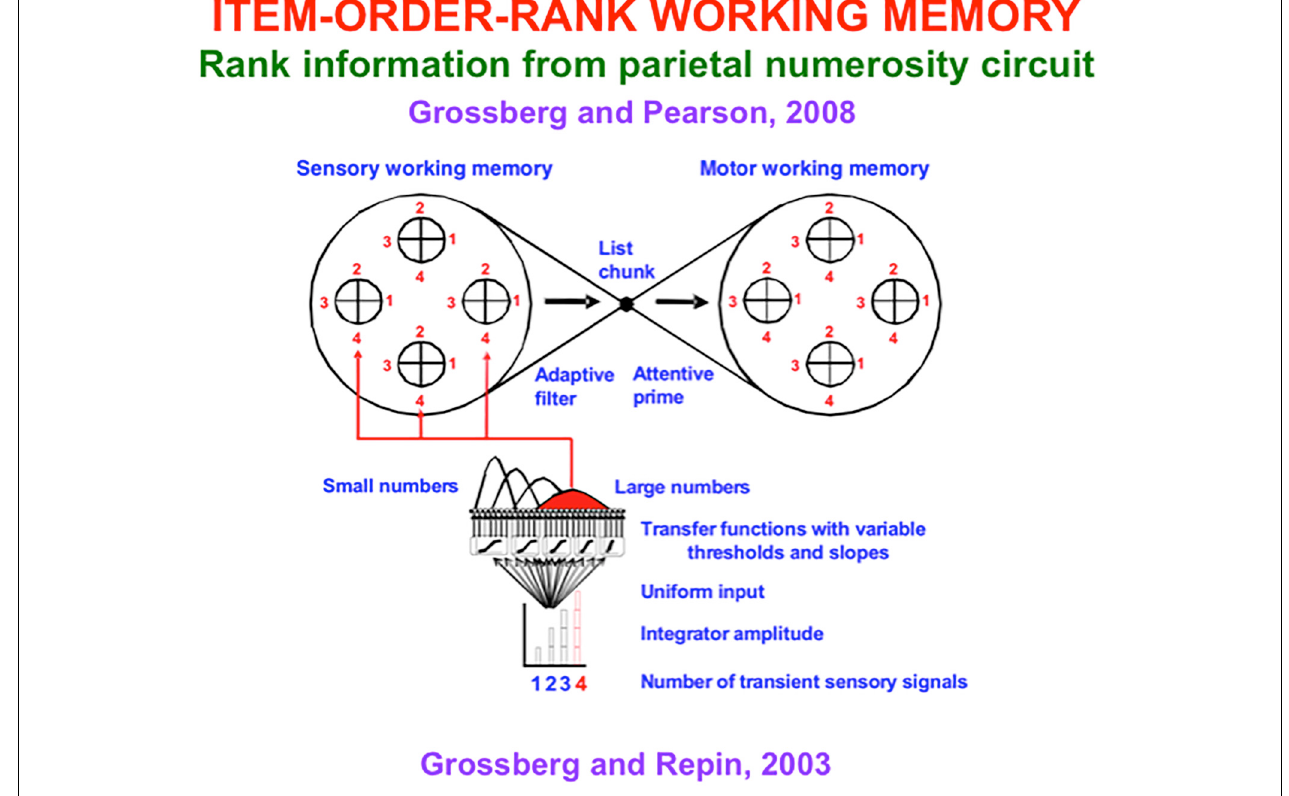
FIGURE 9 | Circuit for encoding a conjunction of item, order, and position in sensory and motor working memory. Cells in the sensory and motor working memories need a second input that codes positional information in order to fire. The model proposes that number maps in parietal and frontal cortex provide this positional information. The circles with numbers represent cortical hypercolumns, each coding a different sensory or motor event, with positions (for illustration) 1, 2, 3, and 4. The sensory working memory supports learning of list chunks. The list chunks learn to attentively prime the Item-Order-Rank motor working memory during reactive performance of a sequence of actions. During planned performance, cells in the motor working memory fire their motor commands when they receive a list chunk priming signal and the correct positional, or rank, input from the corresponding number map. The lower part of the figure illustrates how transient inputs in response to each sensory event are integrated into a signal proportional to the total number of sensory inputs that have occurred in the sequence. This integrated signal generates a uniform input to all the cells in the parietal number map. The signal functions with variable thresholds and slopes in the number map cause distinct populations of cells to get activated as a larger number of transients is stored. The number map cells broadcast their positional information to the sensory working memory. A similar scheme occurs in the motor working memory. [Reprinted with permission from Grossberg and Pearson